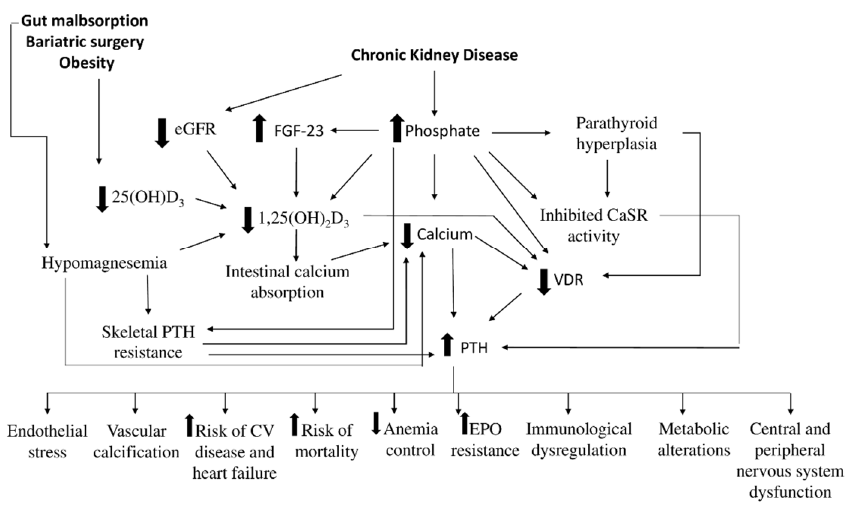
Figure 1. Mechanisms of secondary hyperparathyroidism.